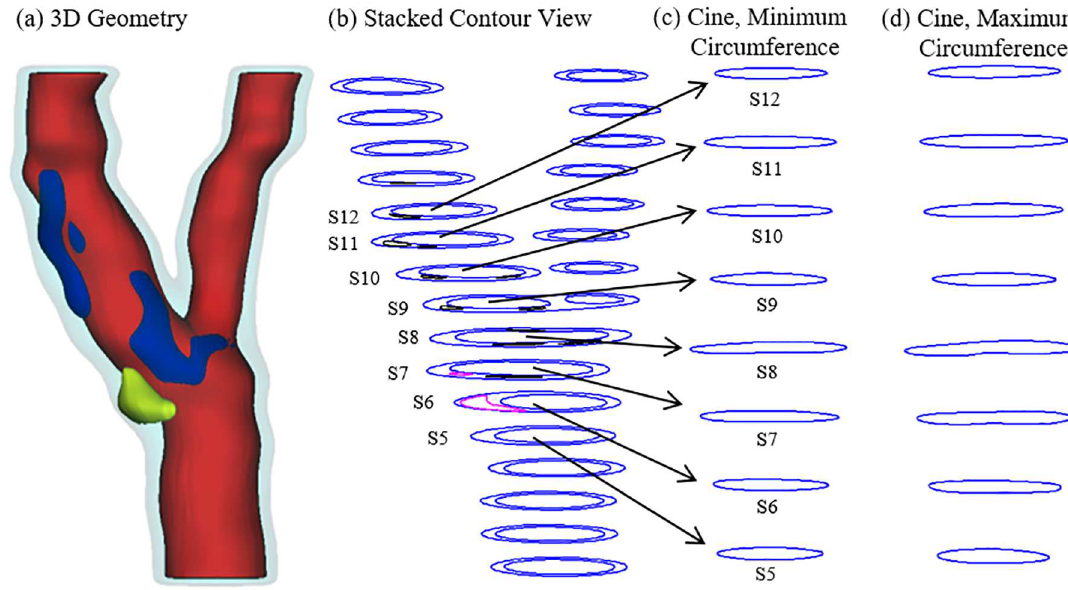
Fig 2. A human carotid plaque sample with matching Cine slices. (a) 3D plaquegeometry reconstructed from MRI; (b) Stacked contours; (c) MatchingCine contours with minimum circumference; (d) MatchingCine contours with maximum